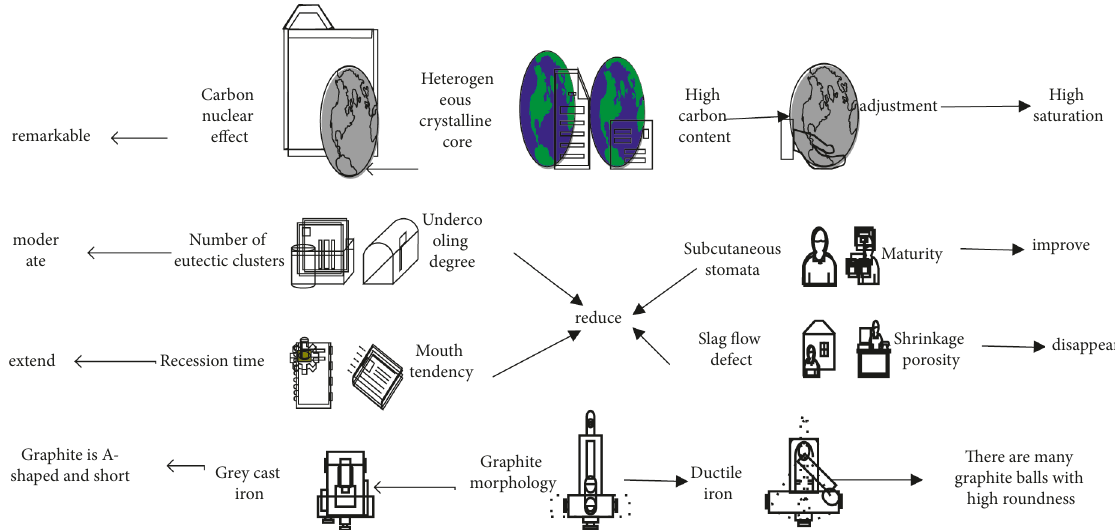
Figure 8: Inoculation and associated functions of silicon